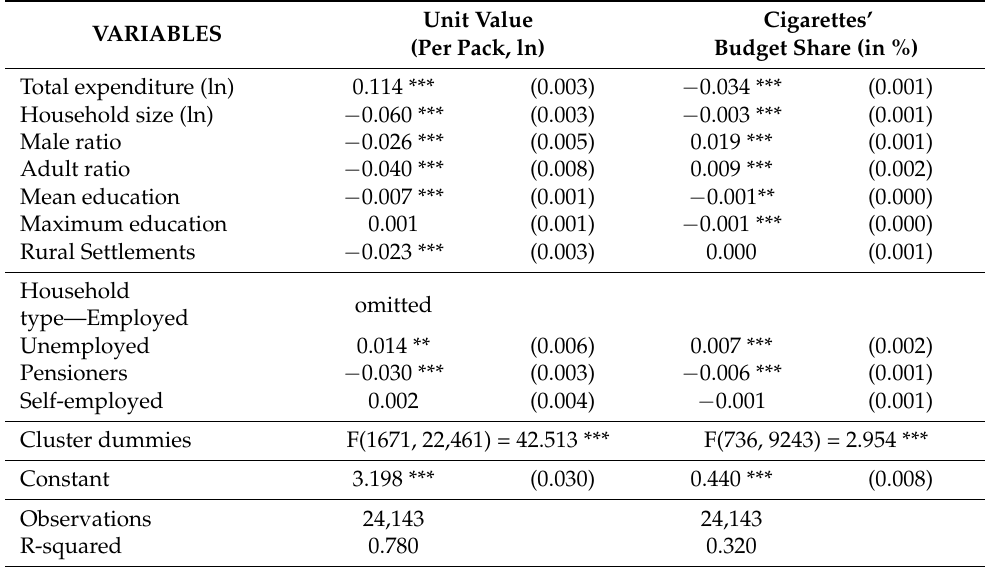
Table A2. First-stage regression results for Deaton model.